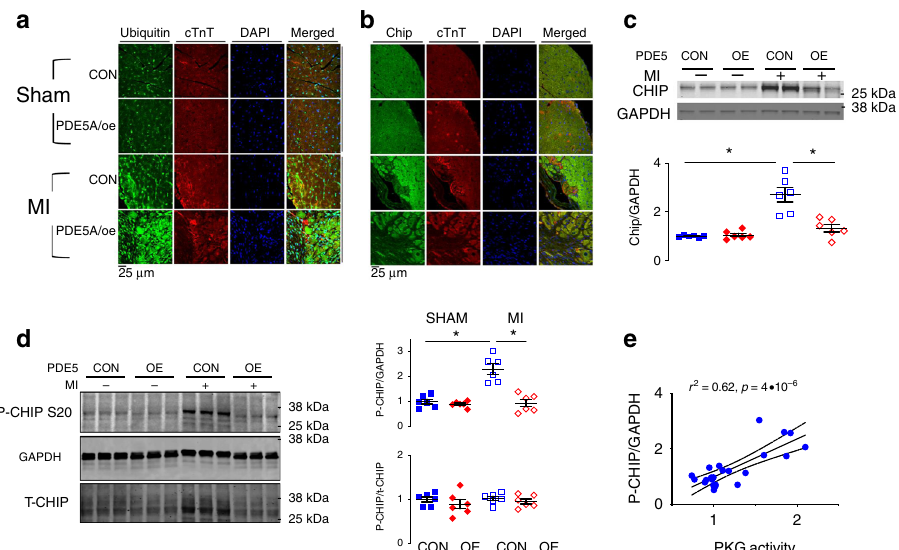
Fig. 5 Impact of reduced in vivo myocyte PKG activity on CHIP. a Fluorescent confocal images of transverse myocardial sections with antibody staining for ubiquitin (green), cardiac troponin T (cTnT, red), and nuclei (DAPI, blue). There is increased myocyte ubiquitin staining after MI in mPDE5/ oe myocardium. b Fluorescent confocal images of same myocardium stained for CHIP (green), cTnT, and DAPI. Myocyte CHIP expression is reciprocally reduced in mPDE5/ oe heart after MI. Each examination performed with biological duplicates. c Representative Western blot and summary data for total CHIP expression in both experimental groups at baseline (CON) and after MI. n = 6 biological replicates, 2WANOVA, p = 0.0011 for interaction of group and + / − MI; Tukey mct: * p < 5 × 10 − 6 . d Example immunoblot and summary results for phospho-S20 CHIP, and ratio of pCHIP to total CHIP in peri-infarct zone before and after MI. n = 6 biological replicates; 2WANOVA ( p = 0.0002 for interaction term); Tukey mct: * p = 10 − 5 . e Myocardial PKG activity directly correlates with levels of p/t CHIP. Data are from MI study with rest and post MI data pooled in the two groups. Source data are provided as a Source Data fi le. Individual data and mean ± SEM shown in each summary panel.